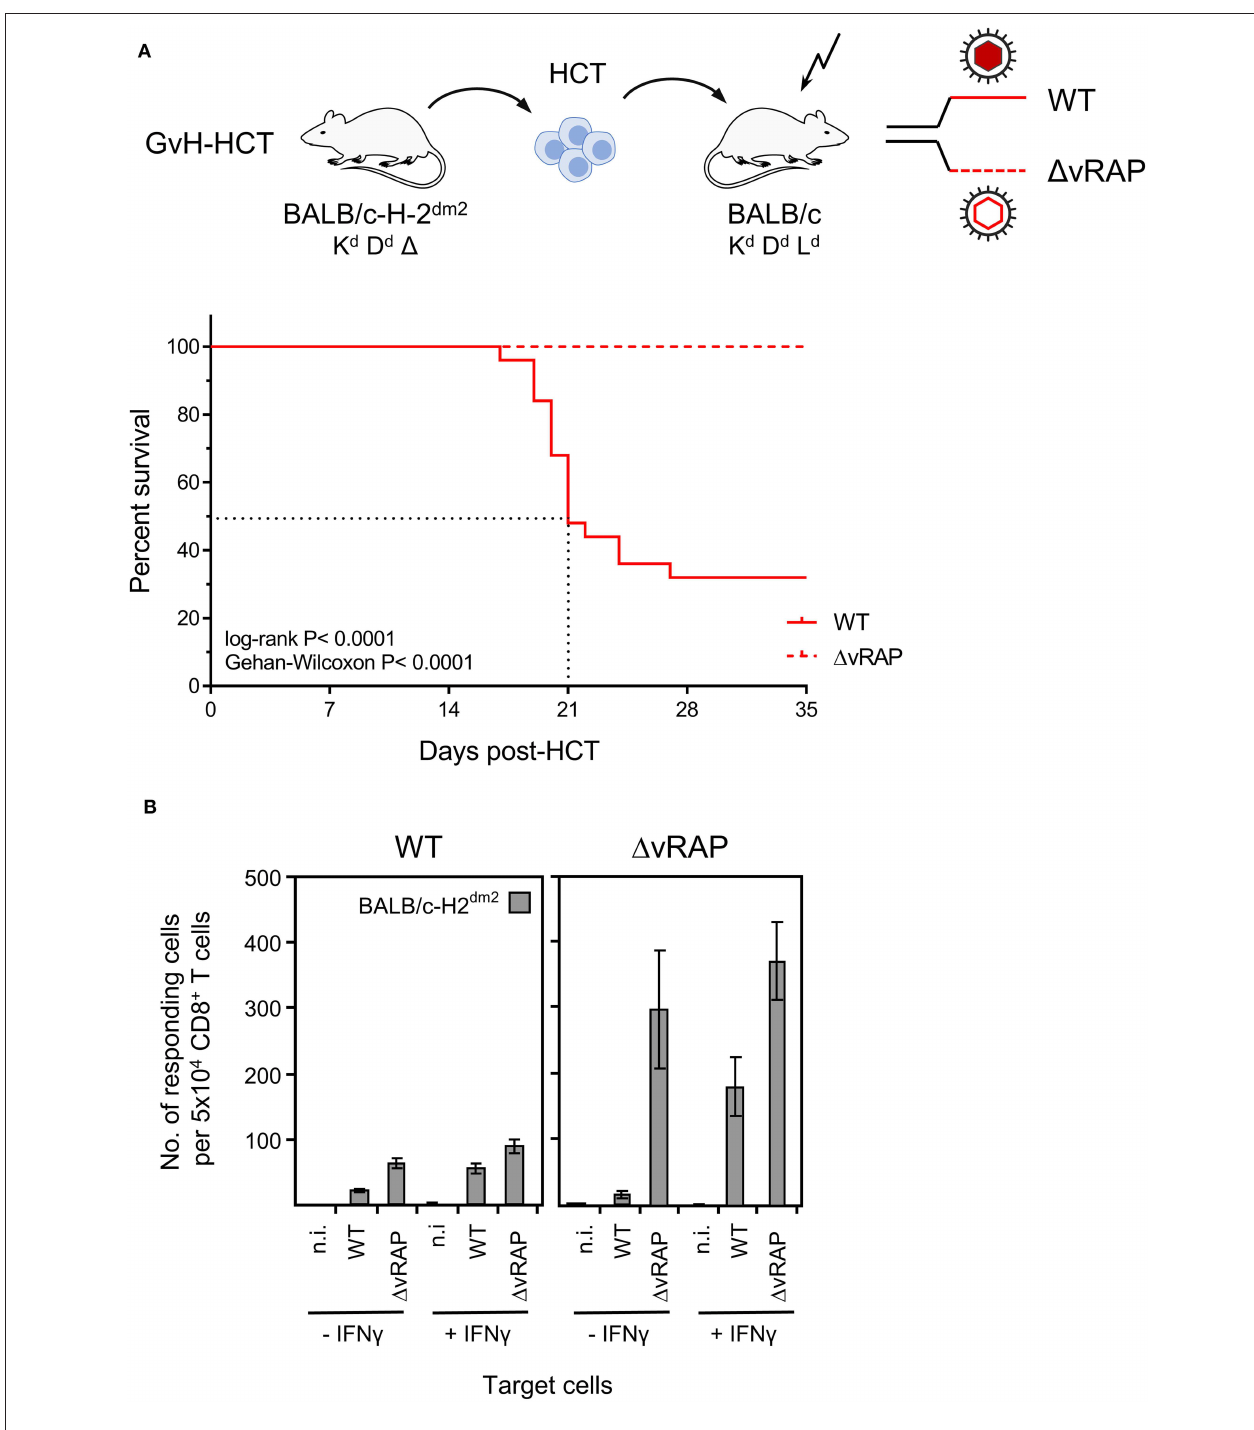
FIGURE 9 | Rescue of GvH-HCT recipients by deletion of immune evasion genes for improving antigen presentation. (A) Sketch of the GvH-HCT protocol (top) and resulting Kaplan-Meyer survival plots after infection of the recipients with wild-type (WT) virus or a virus in which ‘viral regulators of antigen presentation’ (vRAP) are deleted ( 1 vRAP). (B) Improvement of antigen presentation by deletion of vRAP or by IFN γ . Liver-infiltrating CD8 + T cells derived on day 20 from livers (pools of 10 livers per group) of GvH-HCT recipients infected with WT virus (left panel) or 1 vRAP virus (right panel) were tested in the IFN γ -based ELISpot assay for recognition of BALB/c-H-2 dm2 MEF that were either left uninfected (n.i., not infected) or were infected with either WT virus or 1 vRAP virus. One set of these three types of target cells was pre-treated with IFN γ ( + IFN γ ), another set was left untreated (-IFN γ ). Bars represent numbers of responding cells. Error bars represent 95% confidence intervals determined by intercept-free linear